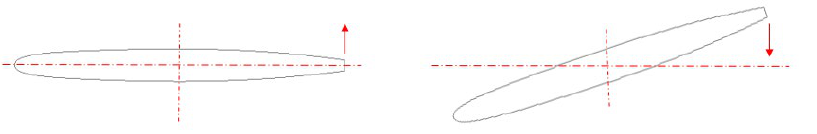
Figure 9. Hydrofoil initial position at t / T = 0 ( left ) and at t / T = 0.25 when it reaches its maximum deformation ( right ). Red arrows indicate the displacement direction.